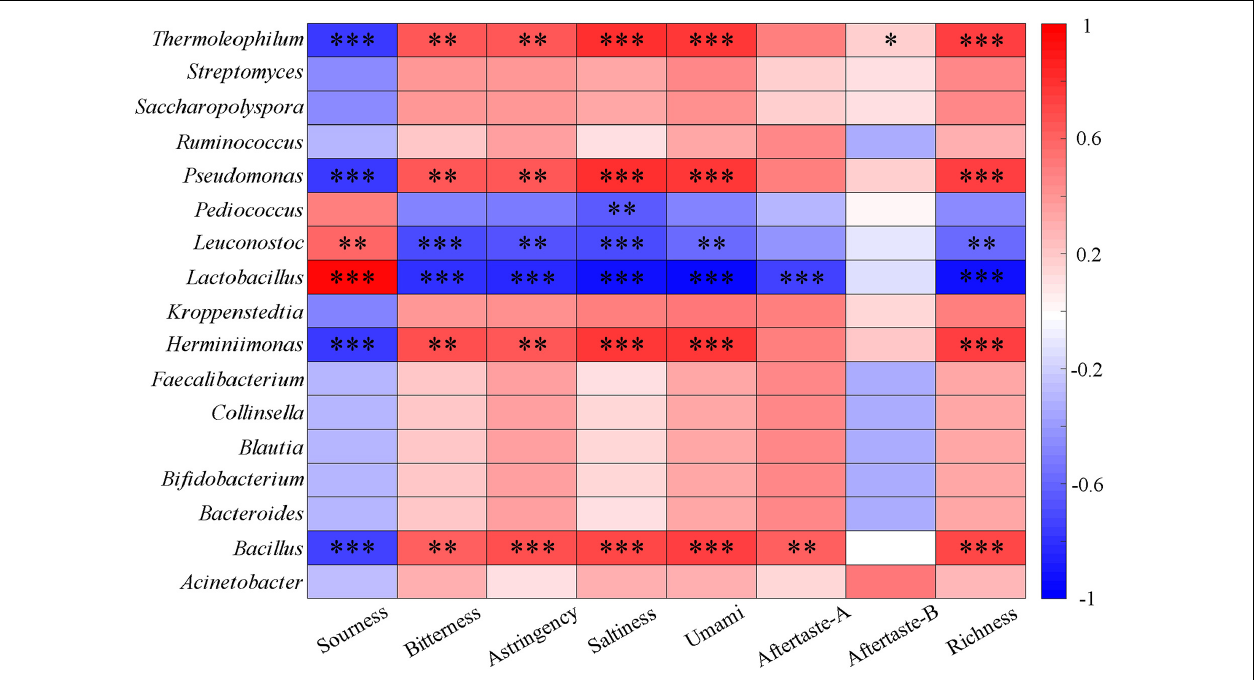
FIGURE 7 | Heatmap of correlation between taste and major bacterial genera of fermented grains ( ∗ 0.01 < P < 0.05, ∗∗ 0.001 < P < 0.01, ∗∗∗ P < 0.001).